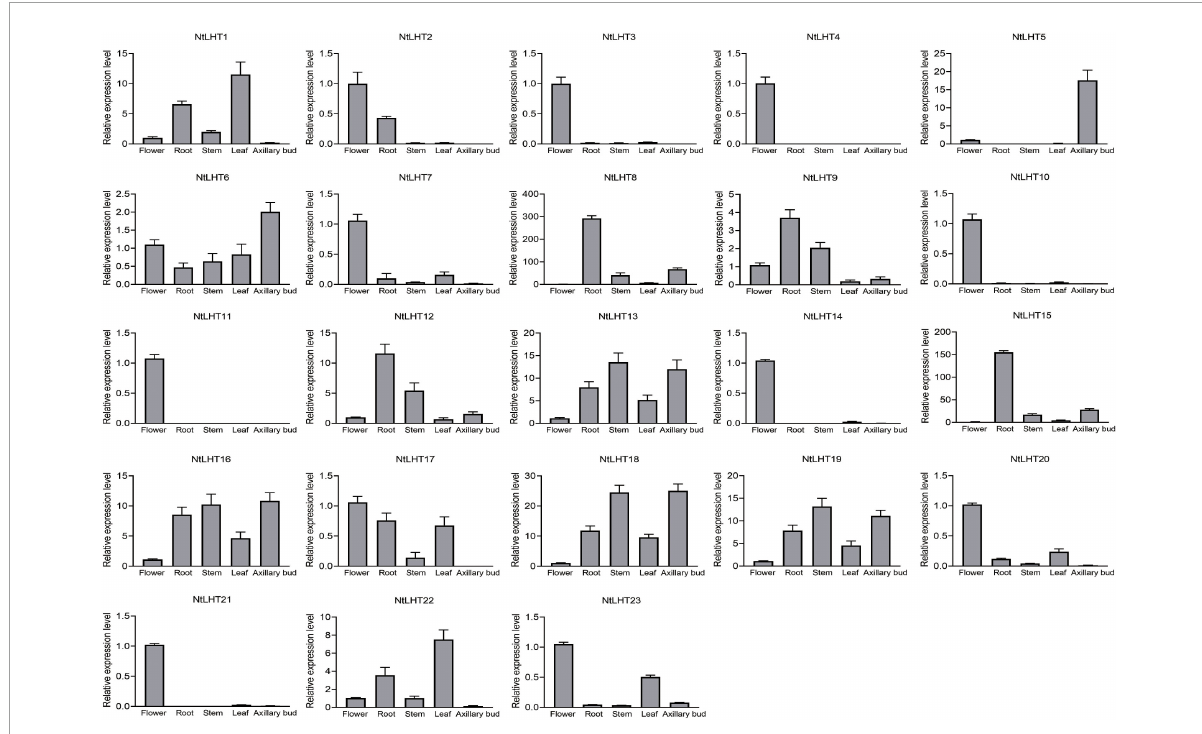
FIGURE5 Analysis of NtLHT expression levels in various tissues. Expression levels in flowers were set to one. The data were presented as means ± SDs ( n = 3).